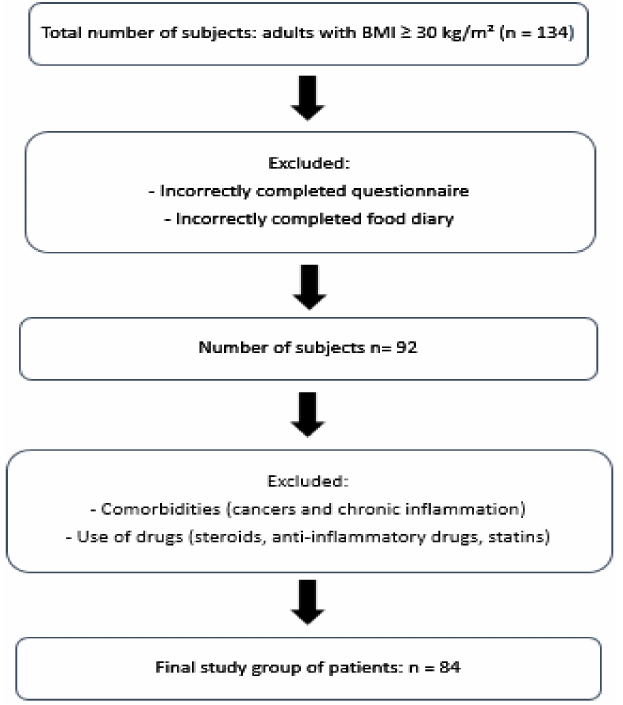
Figure 1. Flow chart demonstrating study’s participants’ selection.